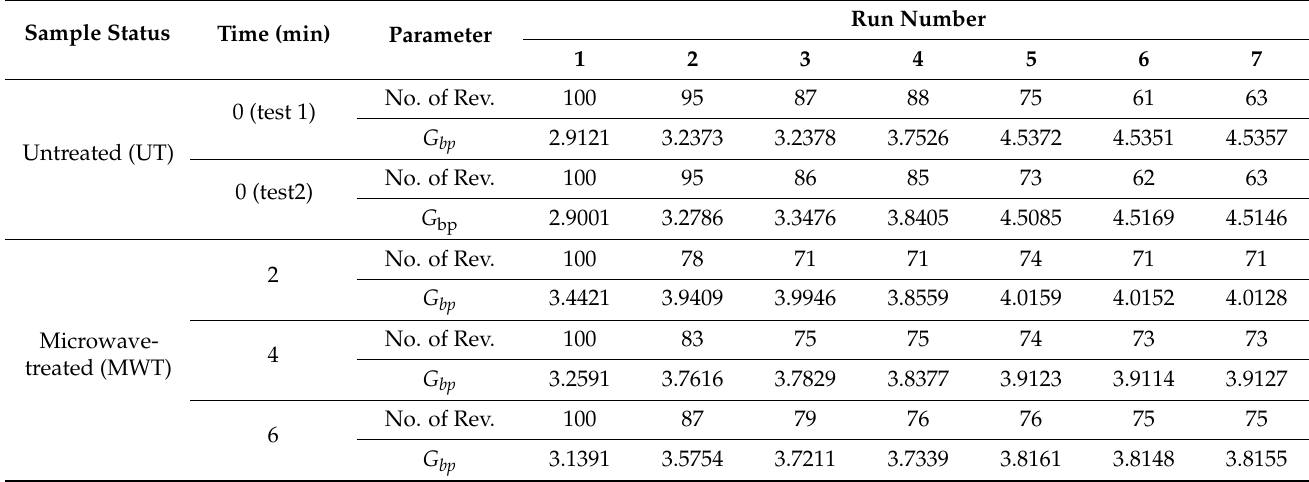
Table 3. Bond Ball mill grindability test results for different runs of sample S2 (sieve test size = 106 µ m, average pack density = 1.5920 g/cm 3